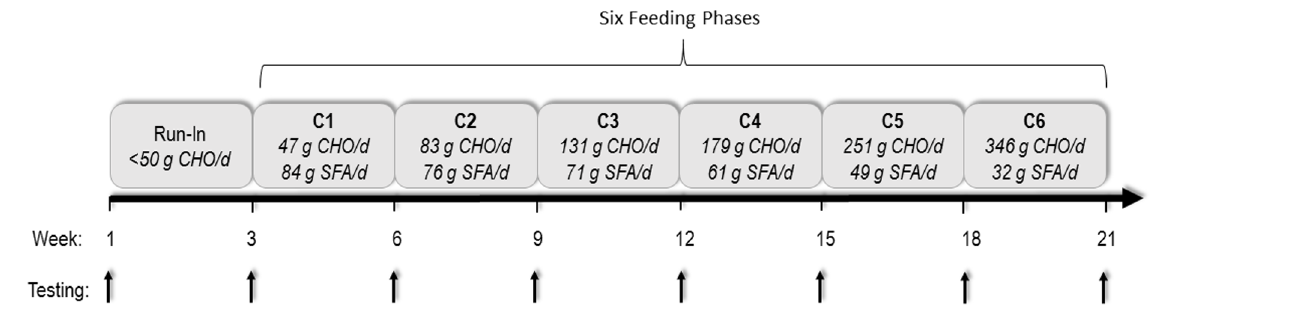
Figure 1. Experimental approach. CHO 5 carbohydrate, SFA 5 saturated